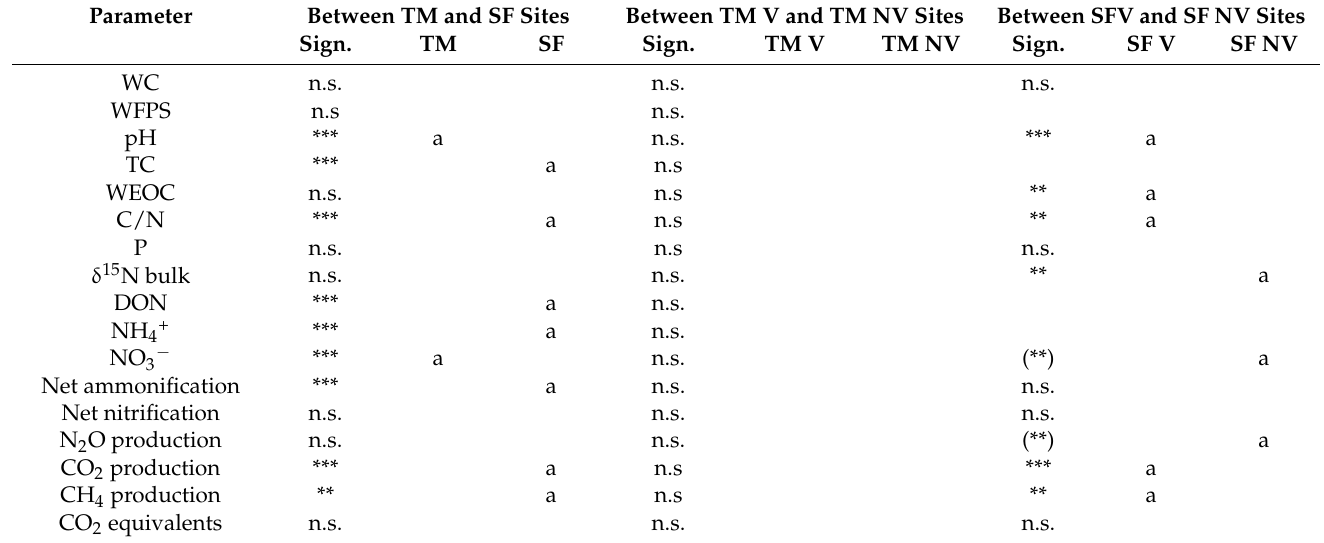
Table 2. Significance of differences between sites: thaw mound (TM) and slump floor (SF)